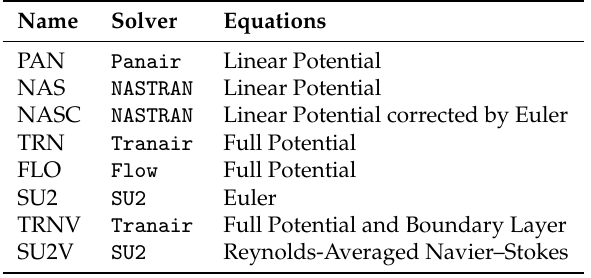
Table 1. Naming convention and equations solved in the present work.